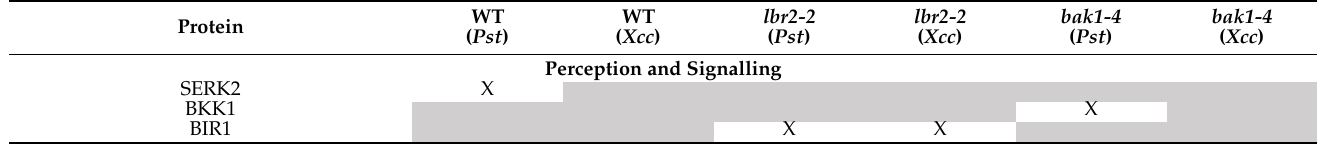
Table 1. Summary of the selected LPS-responsive PM-associated proteins ( # ) from Arabidopsis WT, lbr2-2 and bak1-4 plants treated with LPS from Pst and Xcc . Grey shading indicates proteins not identified in specific line(s) and/or treatment according to significance threshold